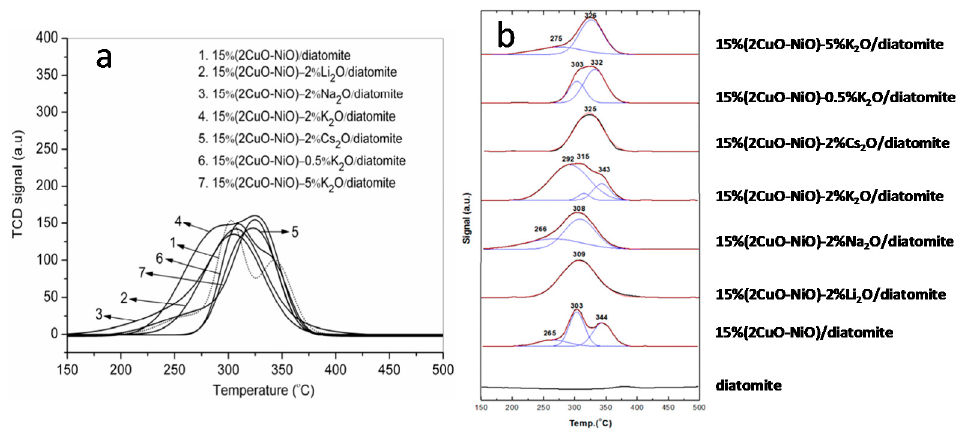
Figure 3. Temperature-programmed reduction (TPR) ( a ) and corresponding fitting curves ( b ) of calcined catalyst precursor.